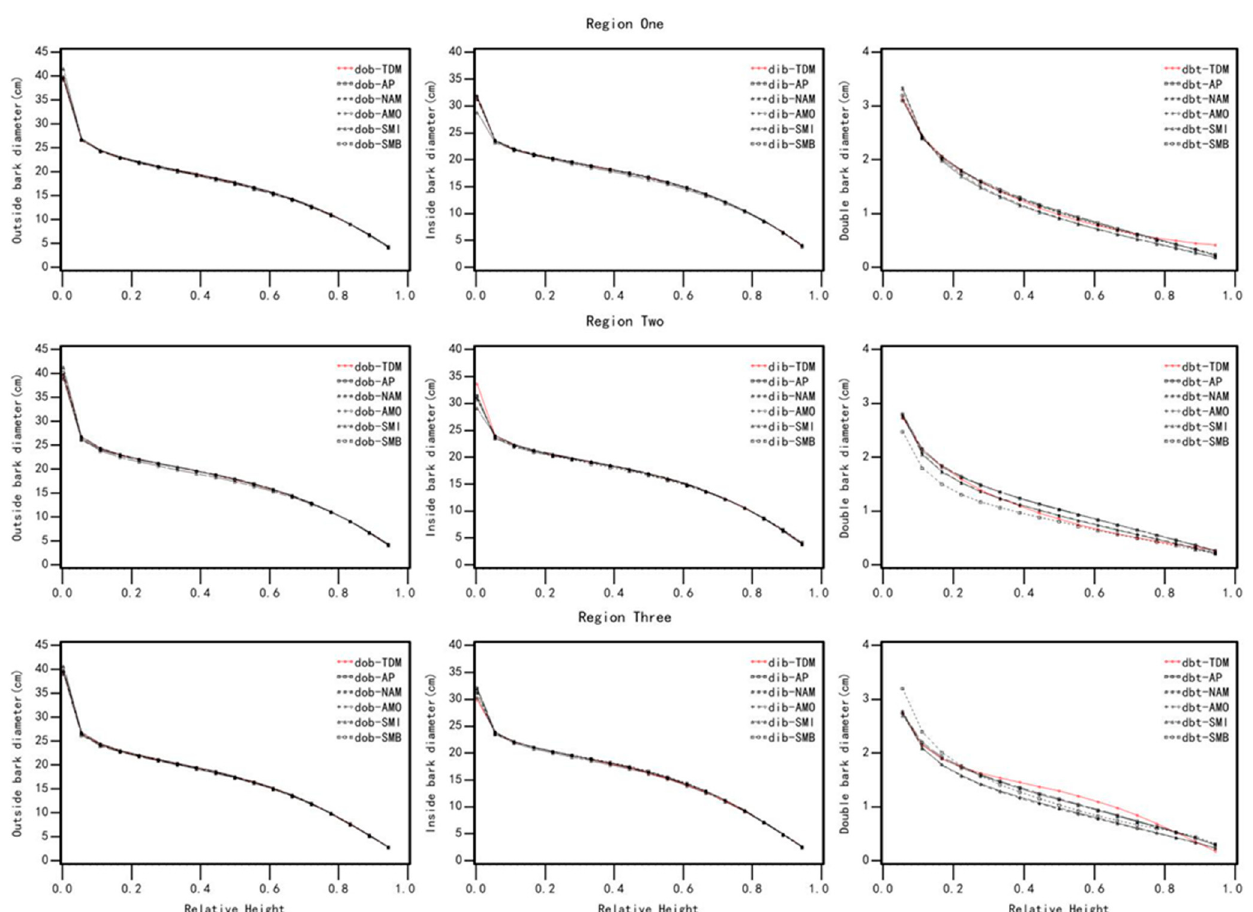
Figure 6. Predicted diameters over relative height using the studied methods for three regions (D = 26, H = 18) .